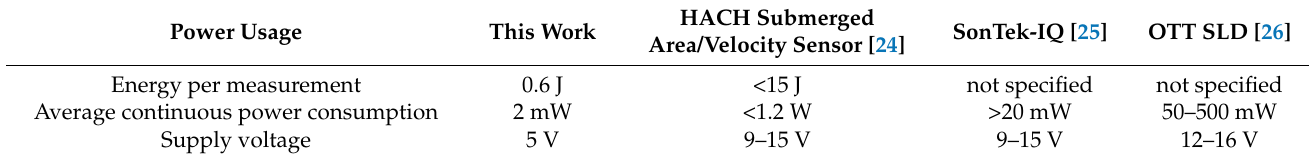
Table 2. Comparison of power usage of velocity sensors to state-of-the-art commercial sensors. Data for commercial sensors are taken from manufacturers documentation. Continuous power consumption is the average power used during use. For the sensor in this work, this is 10 measure- ments per hour. The range of continuous power consumptions for the OTT SLD is due to variable measurement